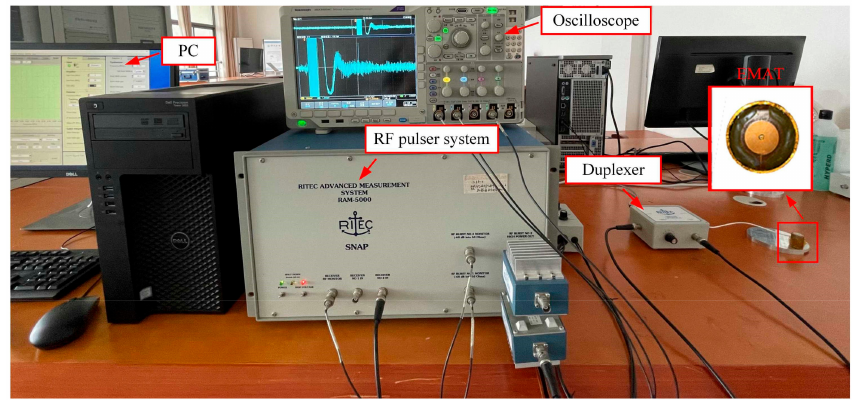
Figure 12. Experimental system diagram.